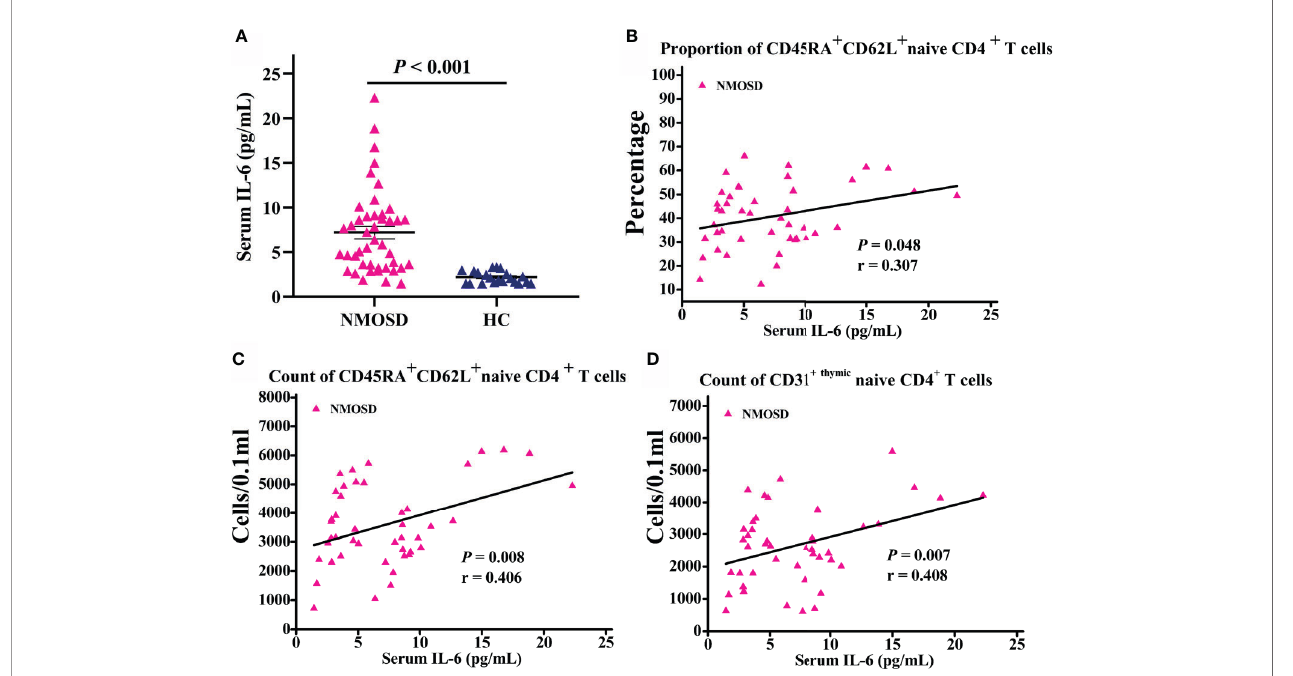
FIGURE 3 | Serum IL-6 level in participants subjected to fl ow cytometric analysis and correlation analysis of naive T cells with IL-6 level. (A) IL-6 levels in NMOSD were signi fi cantly higher than HC; (B – D) Scatter plots showing the correlation of naive T cells with IL-6 level; r = partial correlation coef fi cient after for age and gender. NMOSD, neuromyelitis optica spectrum disorder; HC, healthy